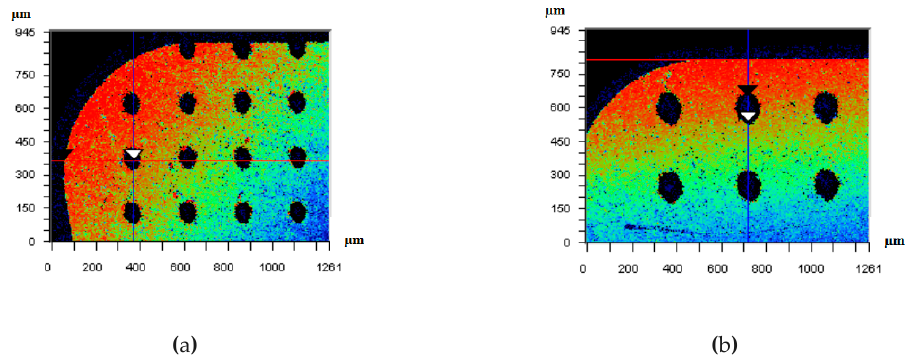
Figure 7. FLY-M10F fully enclosed rotating optical fiber laser marking machine.